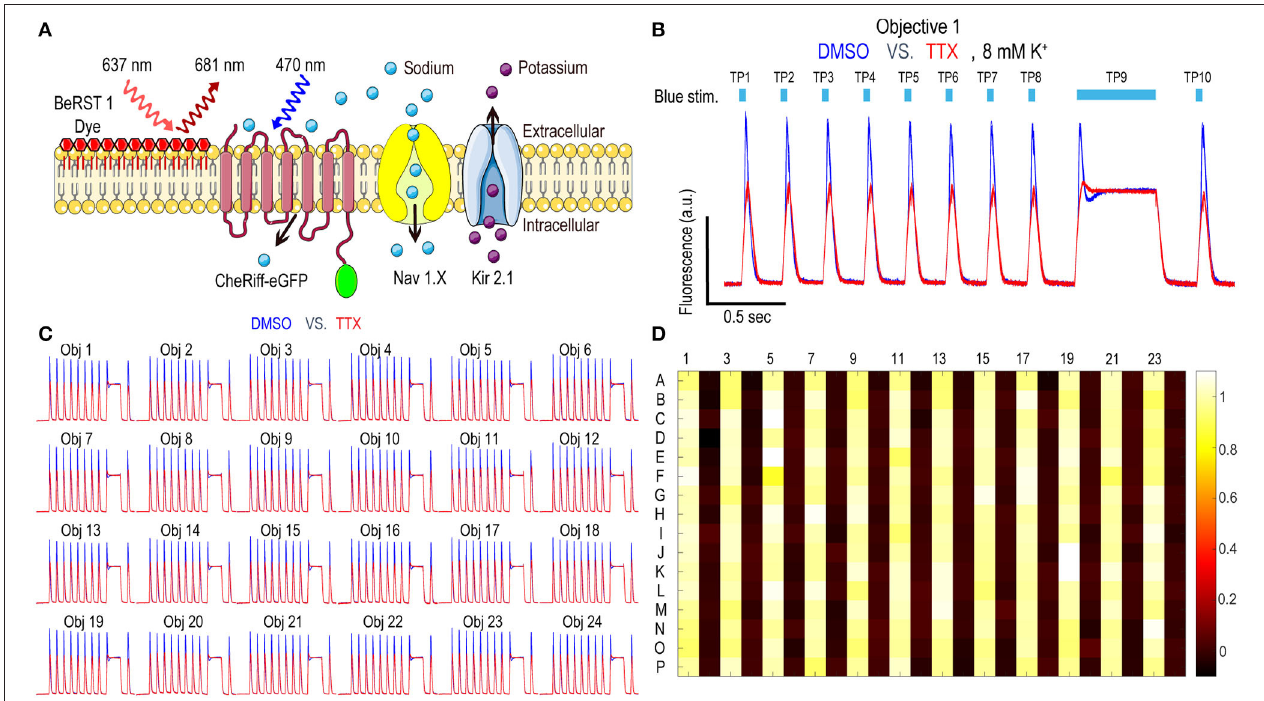
FIGURE 2 | Nav1.7 Spiking HEK assay performance with the Swarm instrument. (A) Diagram of key components in Nav1.x spiking HEK cells, including voltage sensitive dye BeRST1, CheRiff-eGFP, Kir2.1, and the target of interest, Nav1.x channel. (B) Representative fluorescence traces from eight wells of DMSO or 1 µ M TTX treated Nav1.7 spiking HEK cells stimulated with a 10 test-pulse blue light stimulation protocol, imaged by Objective 1 of the Swarm instrument. The bath [K + ] is 8mM. (C) Fluorescence traces collected from all the 24 objectives. The Nav1.7 spiking HEK cells were treated with either DMSO or 1 µ M TTX and were stimulated by the protocol shown in (B) . Each trace was averaged based on 8 adjacent wells imaged by the same objective. (D) The heat map from a representative Nav1.7 spiking HEK 384-well sentinel plate. All the odd columns were treated with DMSO vehicle control, and all the even columns were treated with 1 µ M